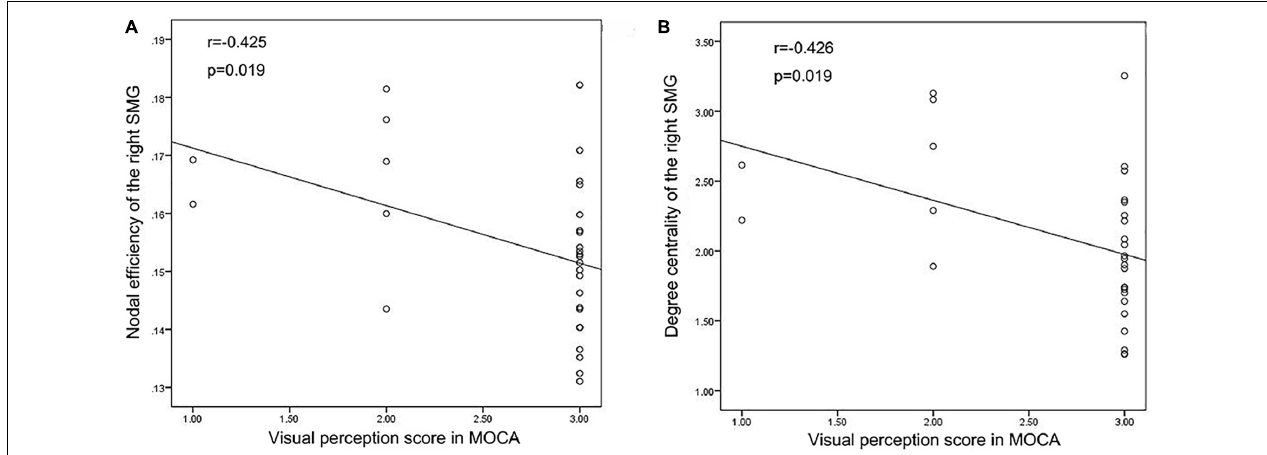
FIGURE 6 | Correlation analysis results. (A,B) Correlation analysis showed that Nodal efficiency and Degree centrality of the right SMG were negatively correlated with the visual perception score in MoCA in TLE